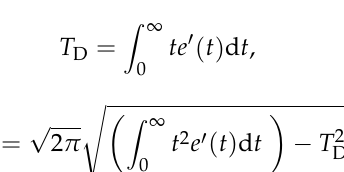
Figure 3. Step response of a system and the definition of settling time ( T S ) based on the delay time ( T D ) and the rise time ( T R ). ( a ) step input ( b ) step response ( c ) impulse response. The step response [( b )] is given by integrating the impulse response [( c )] approximated by a Gaussian function. According to the work by Elmore, T D and T R are approximated using the impulse response of interest e (cid:48) ( t ) , respectively.